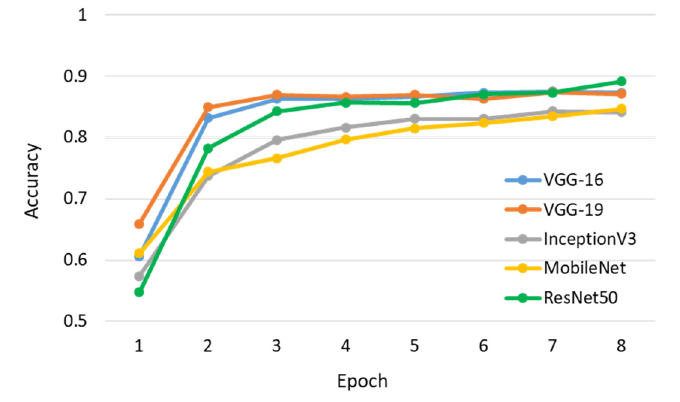
ff erent CNN-based networks. Appl. Sci. 2020 , 10 , x FOR PEER REVIEW